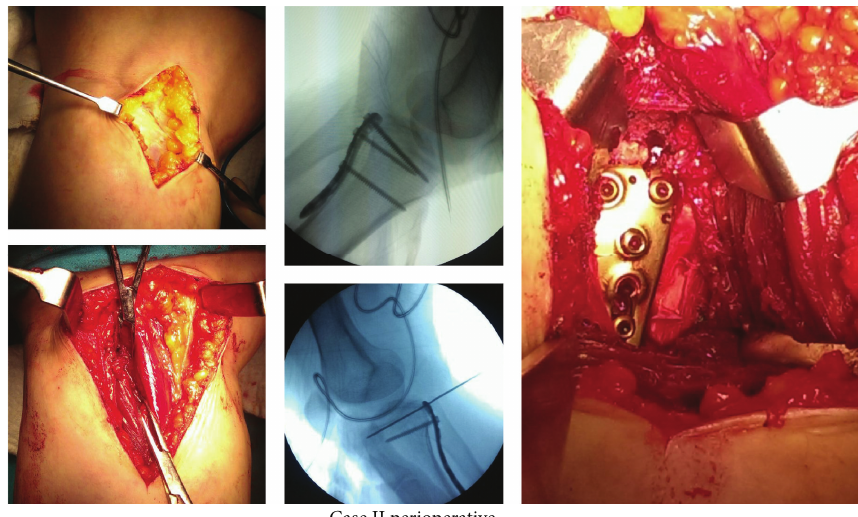
Figure 3: Perioperative photographies and C-arm views of Case II.